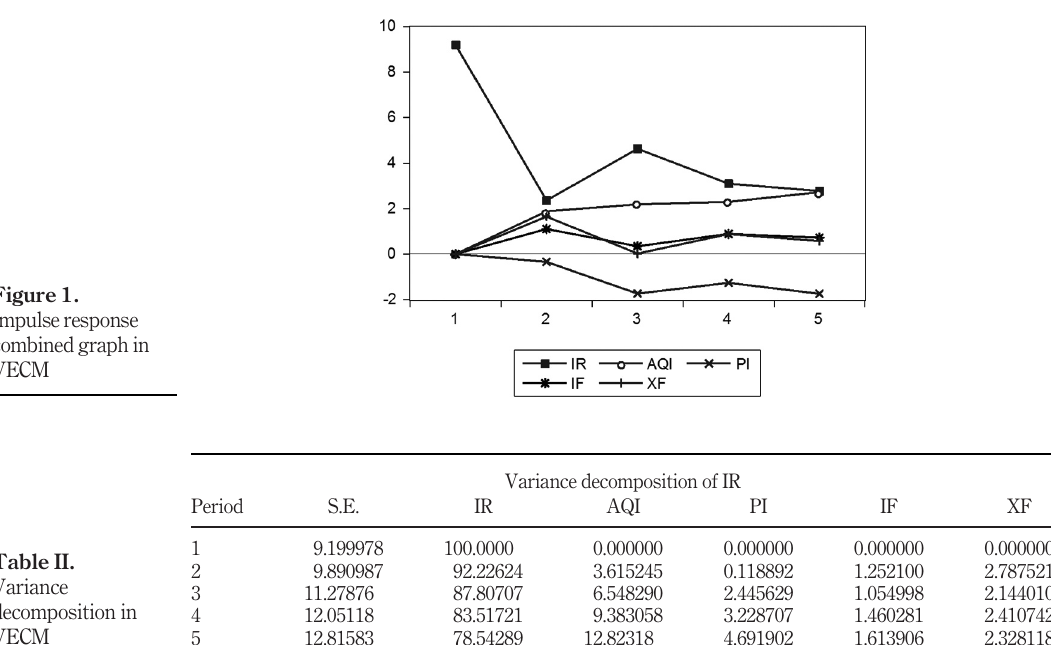
Table II. Variance decomposition in VECM